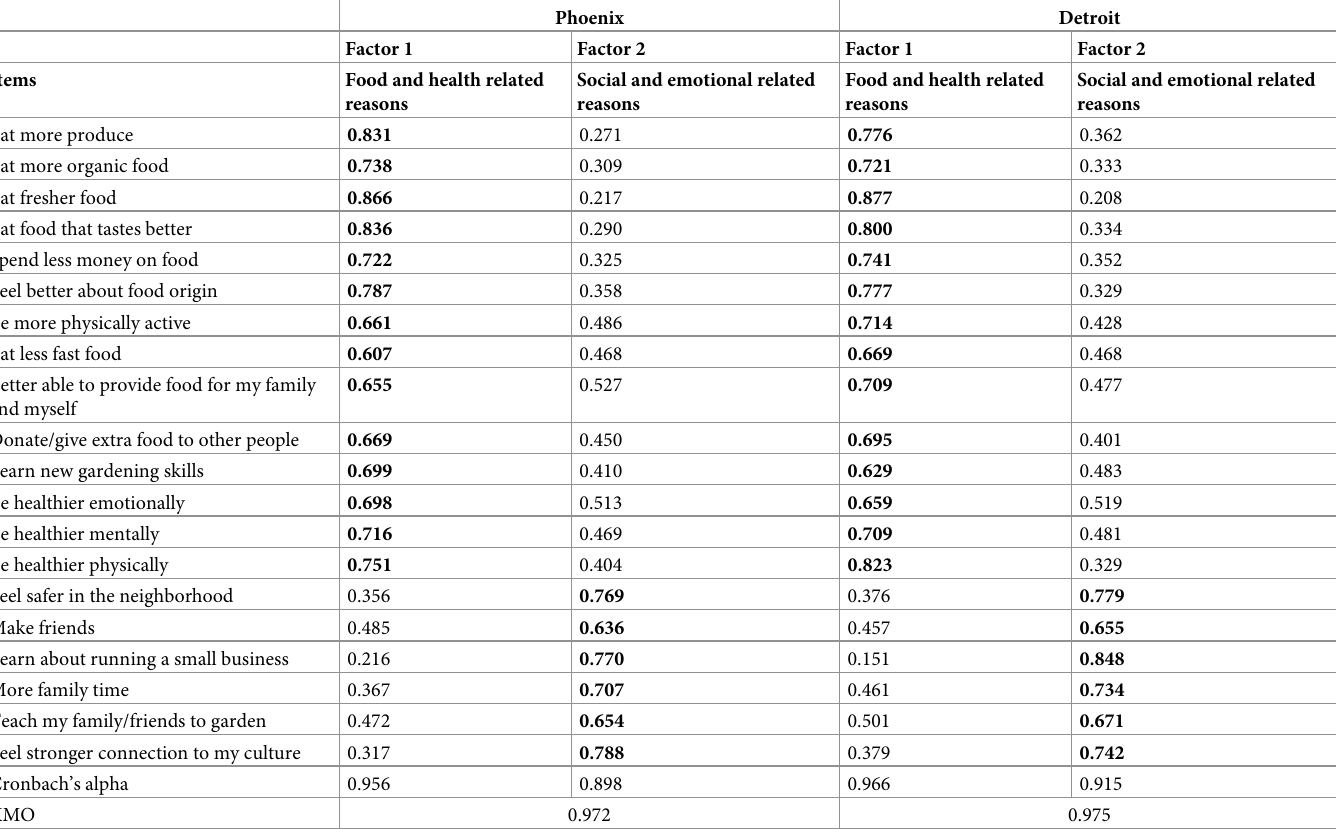
Table 4. Factor analysis of reasons for CG